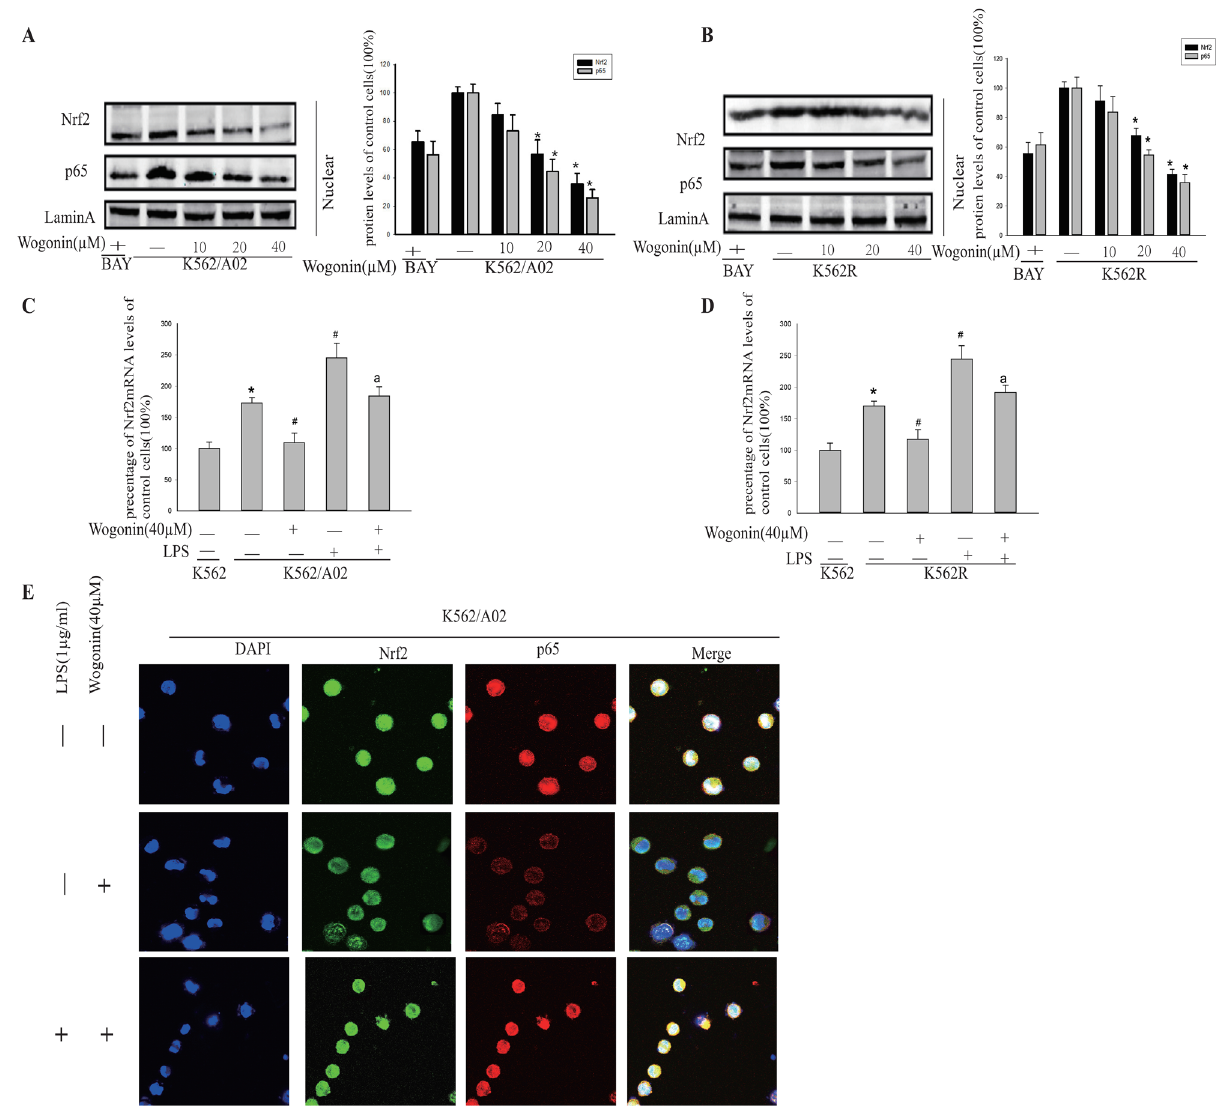
Figure 1. A correct version of original figure